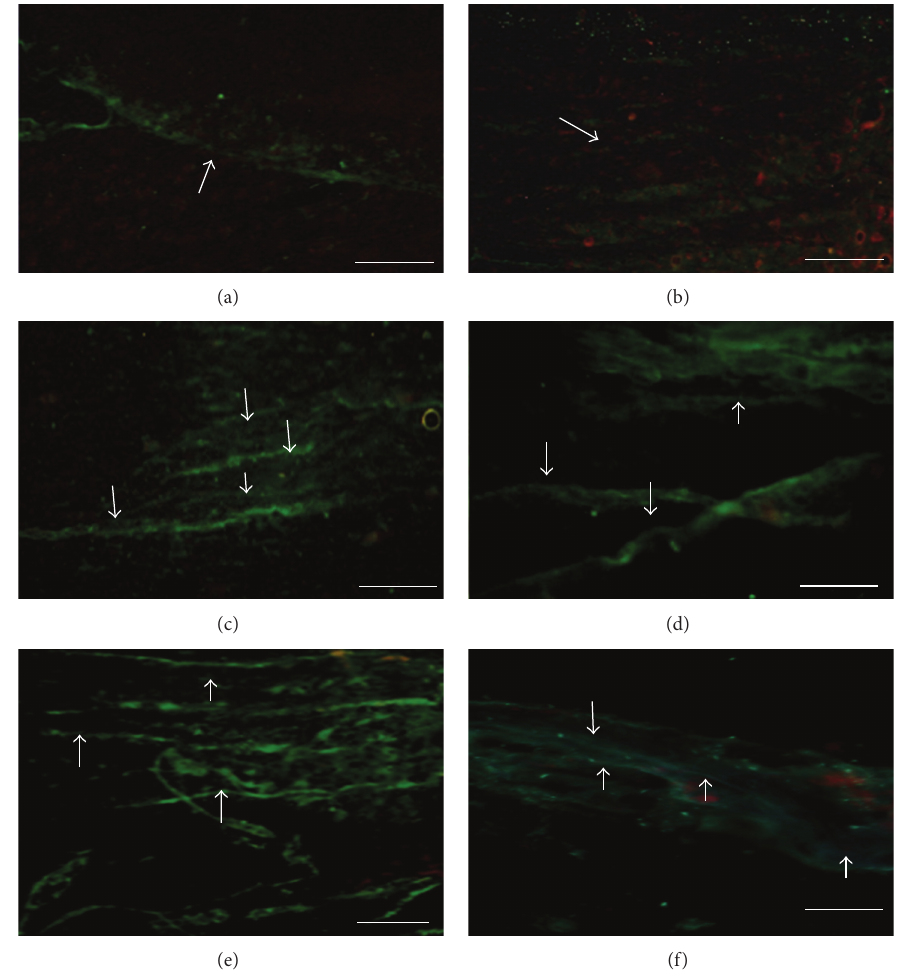
Figure 5: Photomicrography of the expression of Basic Protein Myelin in spinal cord. (a) Control group. (b) Fibrin glue group (FG). (c) PPN group, rostral zone of the SC. (d) PPN + BMSCs group, rostral zone of the SC. (e) PPN group, caudal zone of the SC. (f) PPN + BMSCs group, caudal zone of the SC. A greater quantity of PBM-positive fibers can be observed in panels (c) to (f) (white arrows, Alexa 488, green color) in contrast to panels (a) and (b). All the tissue was contrasted with propidium iodide (nuclei red color). Calibration bar 20 𝜇